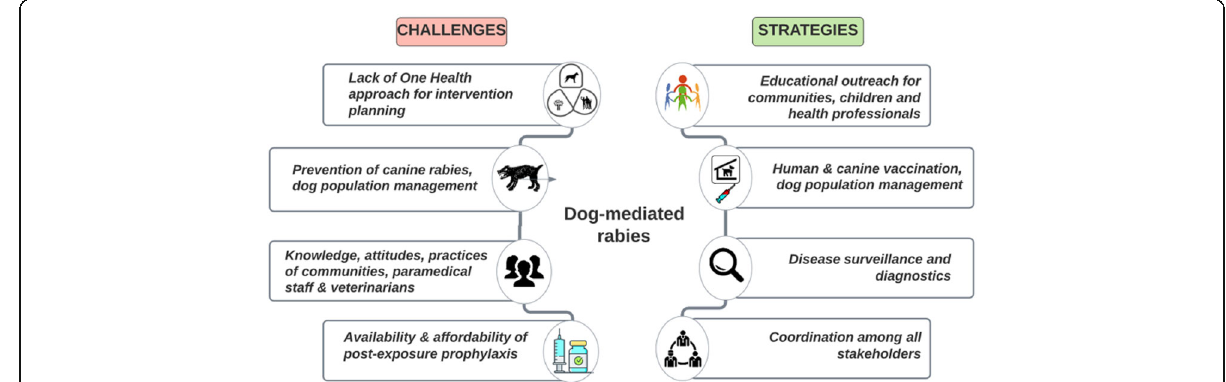
Fig. 1 Diagrammatic representation of challenges and strategies for elimination of dog-mediated rabies in countries where the disease is